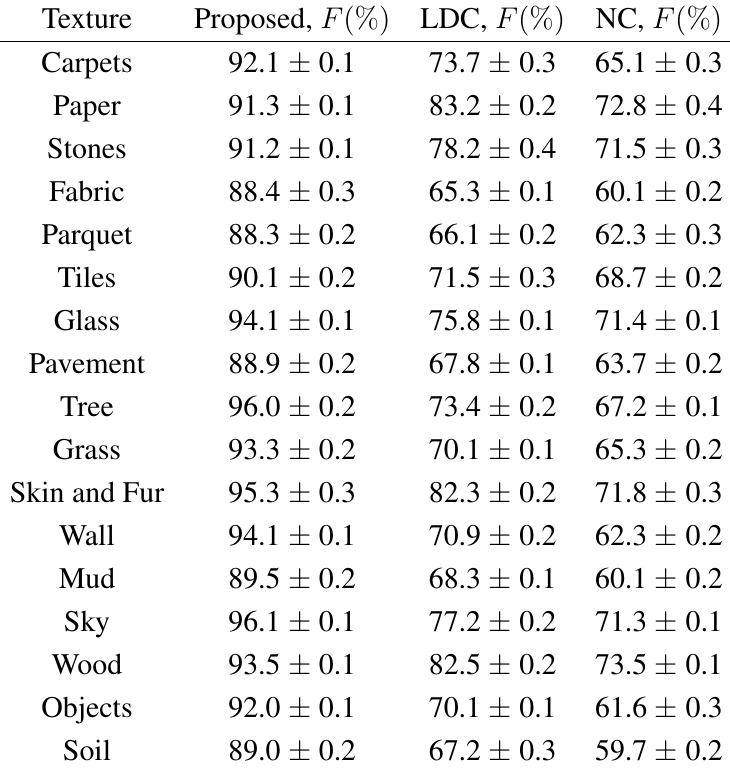
Table 1. Segmentation evaluation by means of F-measure in database GB2S with 17 different background textures, together with the corresponding standard deviation. In addition, the results for LDC and NCut are also provided for comparison.